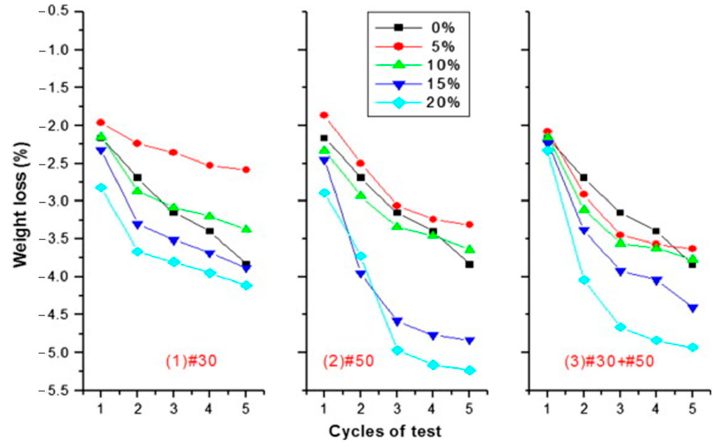
Figure 11. Weight loss after erosion with sodium sulphate solution for SCRC [117].